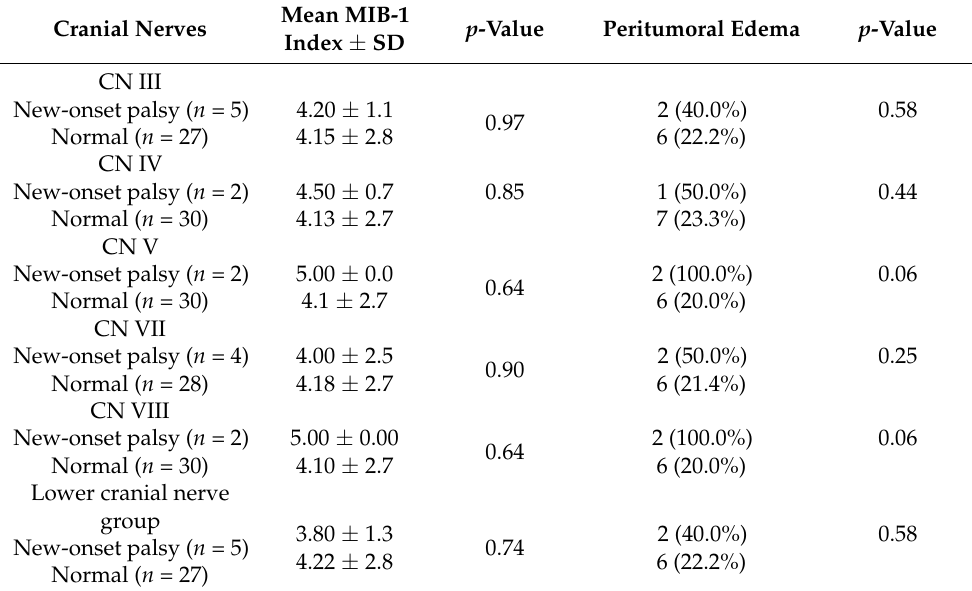
Table 4. Association between MIB-1 labeling index, and peritumoral edema with other new-onset cranial-nerve palsies (using independent t -test and Fisher’s exact test (two-sided)). Mean MIB-1 p -Value Peritumoral Edema p -Value Cranial Nerves Index ± SD CN III New-onset palsy ( n =